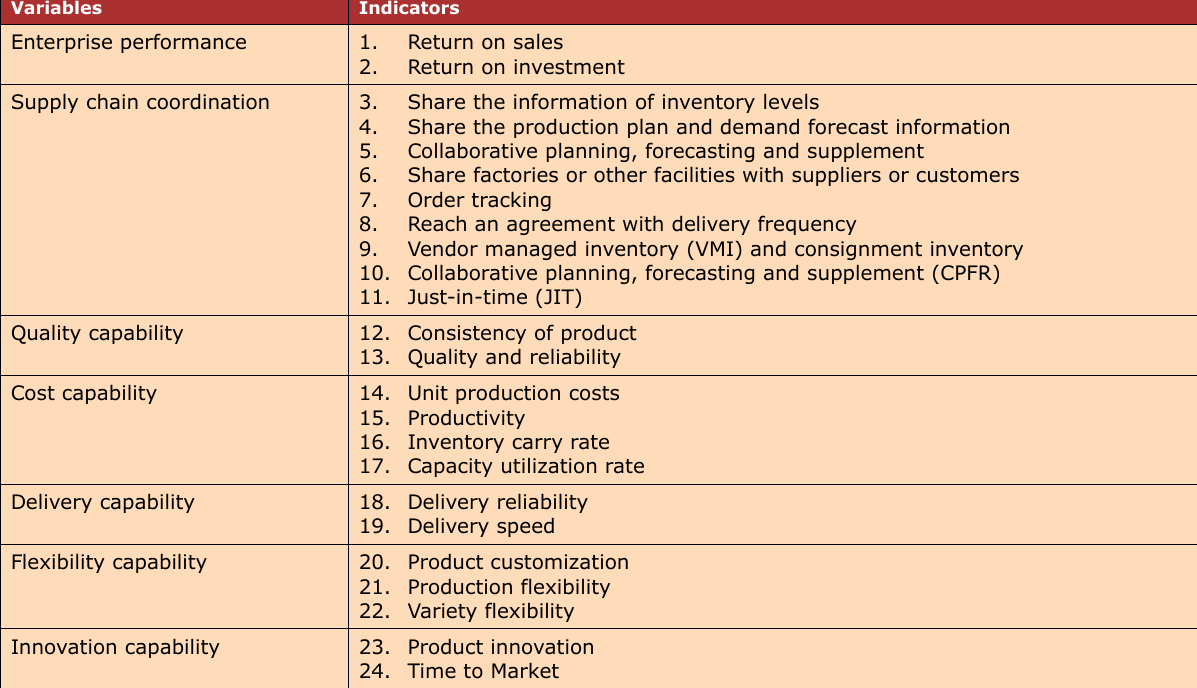
Table 3. Indicators of